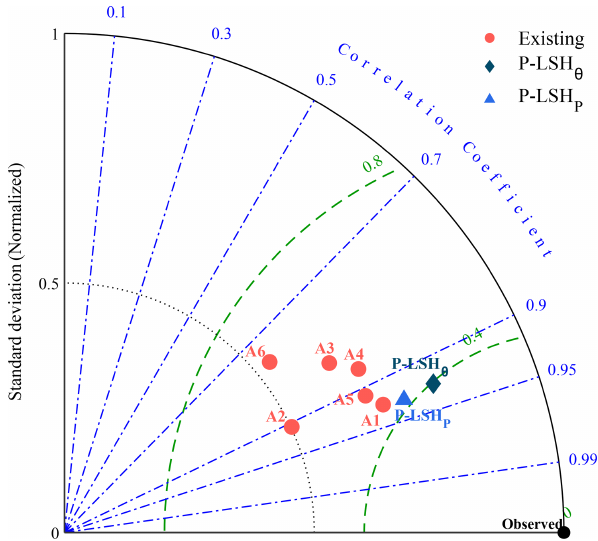
Figure 7. Taylor diagram comparing the retrieved ET by the six existing coupling algorithms and the two improved retrieval algo- rithms (P-LSH θ and P-LSH P ) in the two basins. The green dashed line represents the centered root mean square